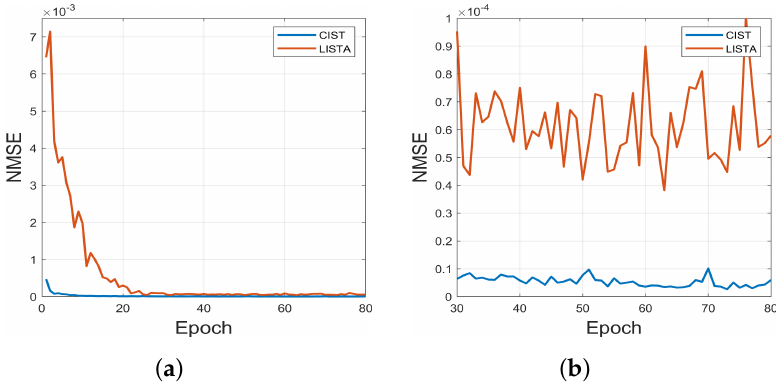
Figure 10. Convergence of CIST and LISTA of Epoch ( a ) from 0 to 80, ( b ) from 30 to